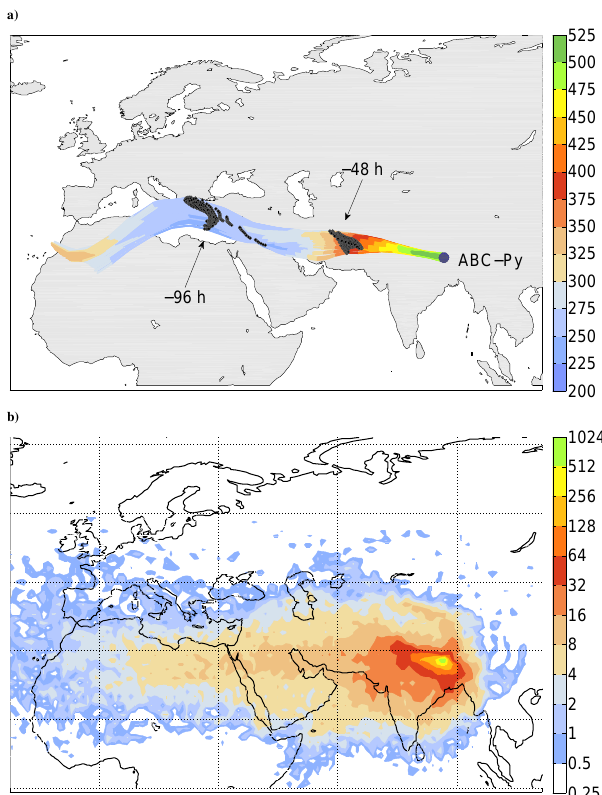
Figure 6. (a) 120h backward trajectories started within 100km from the ABC-Pyramid Atmospheric Research Observatory in the Himalayas (see text) at 18:00UTC on 31 October 2007. The start- ing height is 500hPa and the trajectories are colored according to their pressure (in hPa); the position of the air parcels 48 and 96h before arrival are marked with black dots; (b) density of 120h back- ward trajectories from the Pyramid station started at 500hPa for the whole year 2007. In total, 1460 backward trajectories are included and their 6-hourly positions then gridded onto a 1 ◦ × 1 ◦ latitude– longitude grid. The values give the total counts per grid cells (for details, see